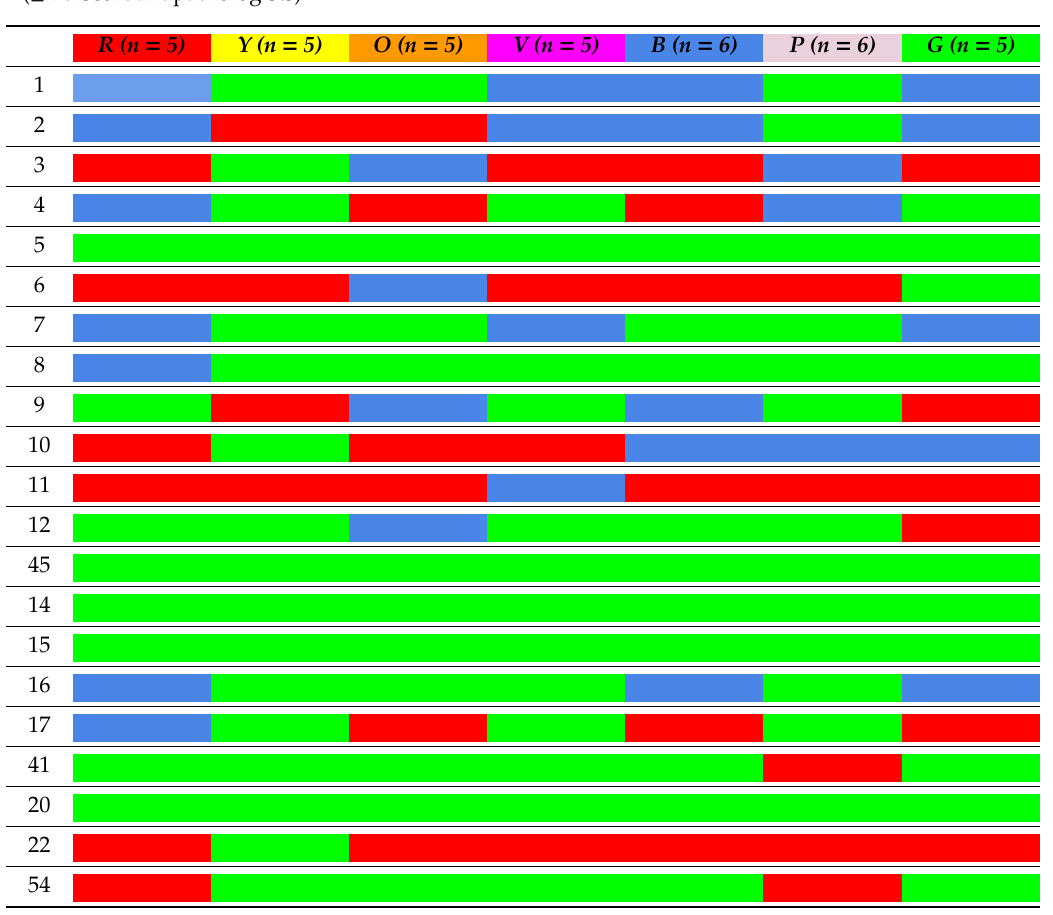
Table 2. This table reports a chromatic scale of the di ff erent diagnostic performances: green (all the participants of the group agreed with the reference score), blue (1 discordant pathologist), and red ( ≥ 2 discordant